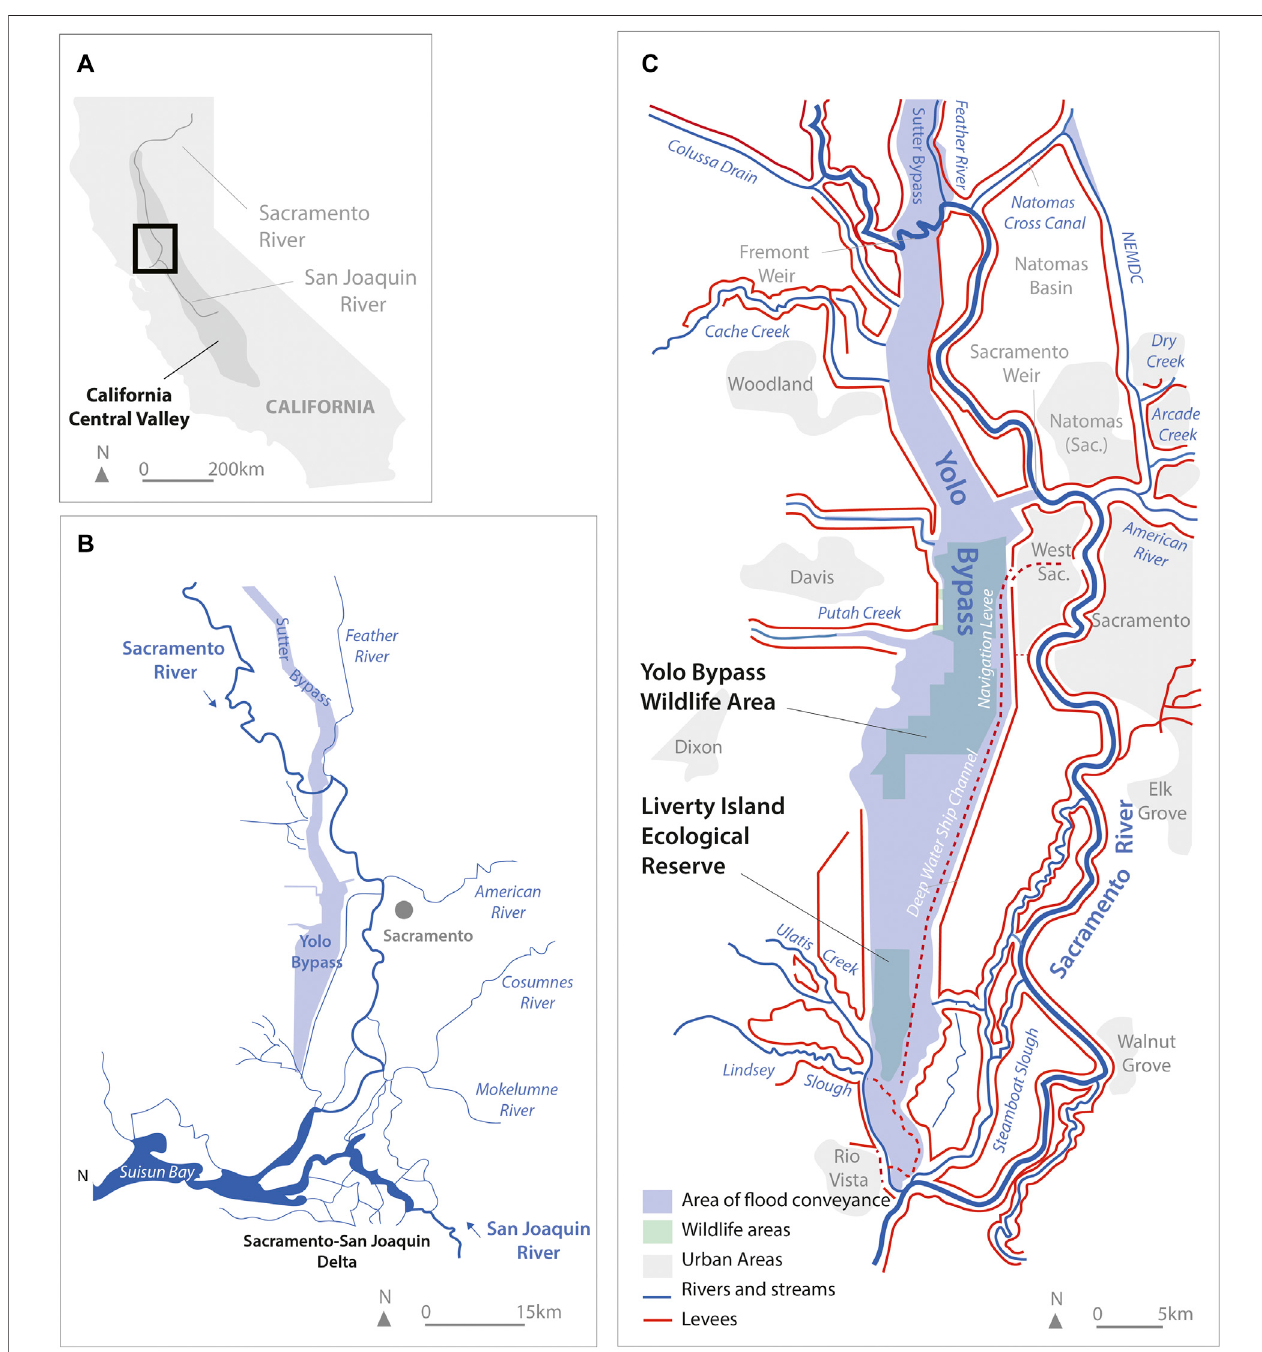
FIGURE 3 | Yolo Bypass Project, California. (A) Location Map (B) Regional Map (C) Yolo Bypass.